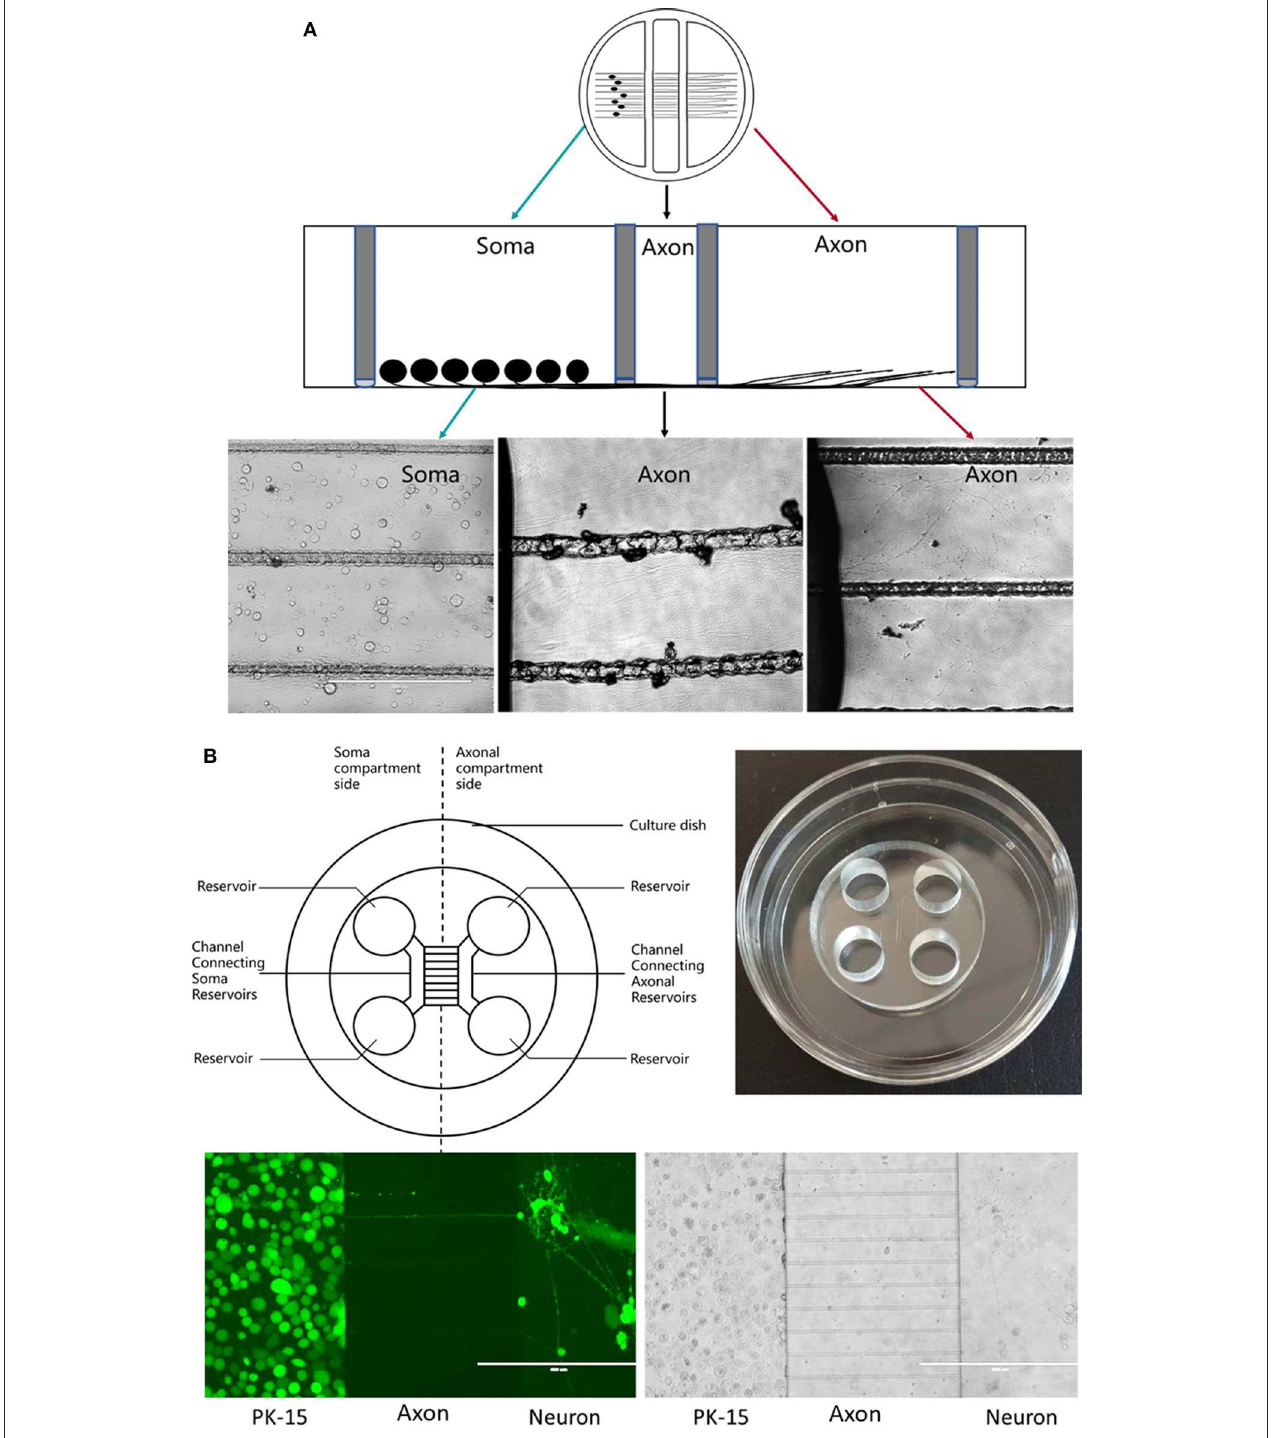
FIGURE 2 | (A) Schematic diagram of a Campenot chamber. The neurons are placed in one chamber and extend their axons into the distal chamber. (B) Schematic diagram of microfluidic device. constant requirements for fluidic flow to maintain diffusion of small molecules; (4) frequency of channel “blockage” during construction and